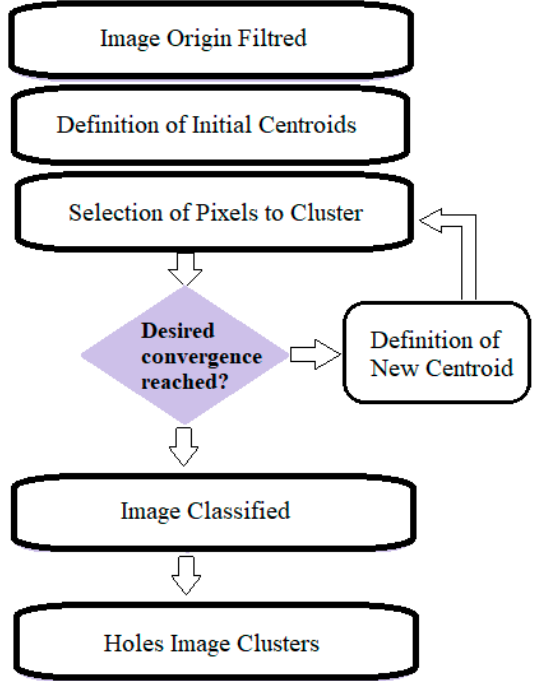
Figure 3. The flow chart of K -means clustering.